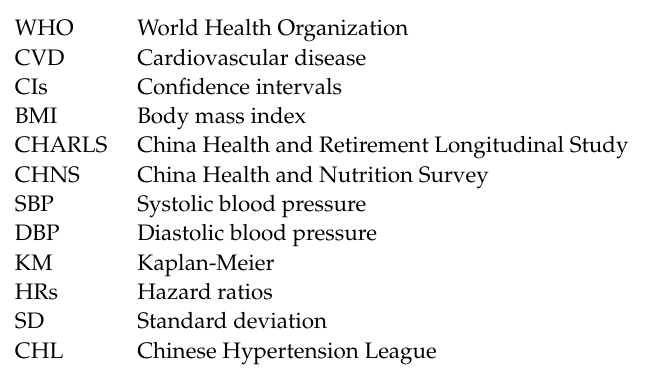
Supplementary Table S1 Hazard ratios of premature death according to BMI and blood pressure categories in the different age and sex